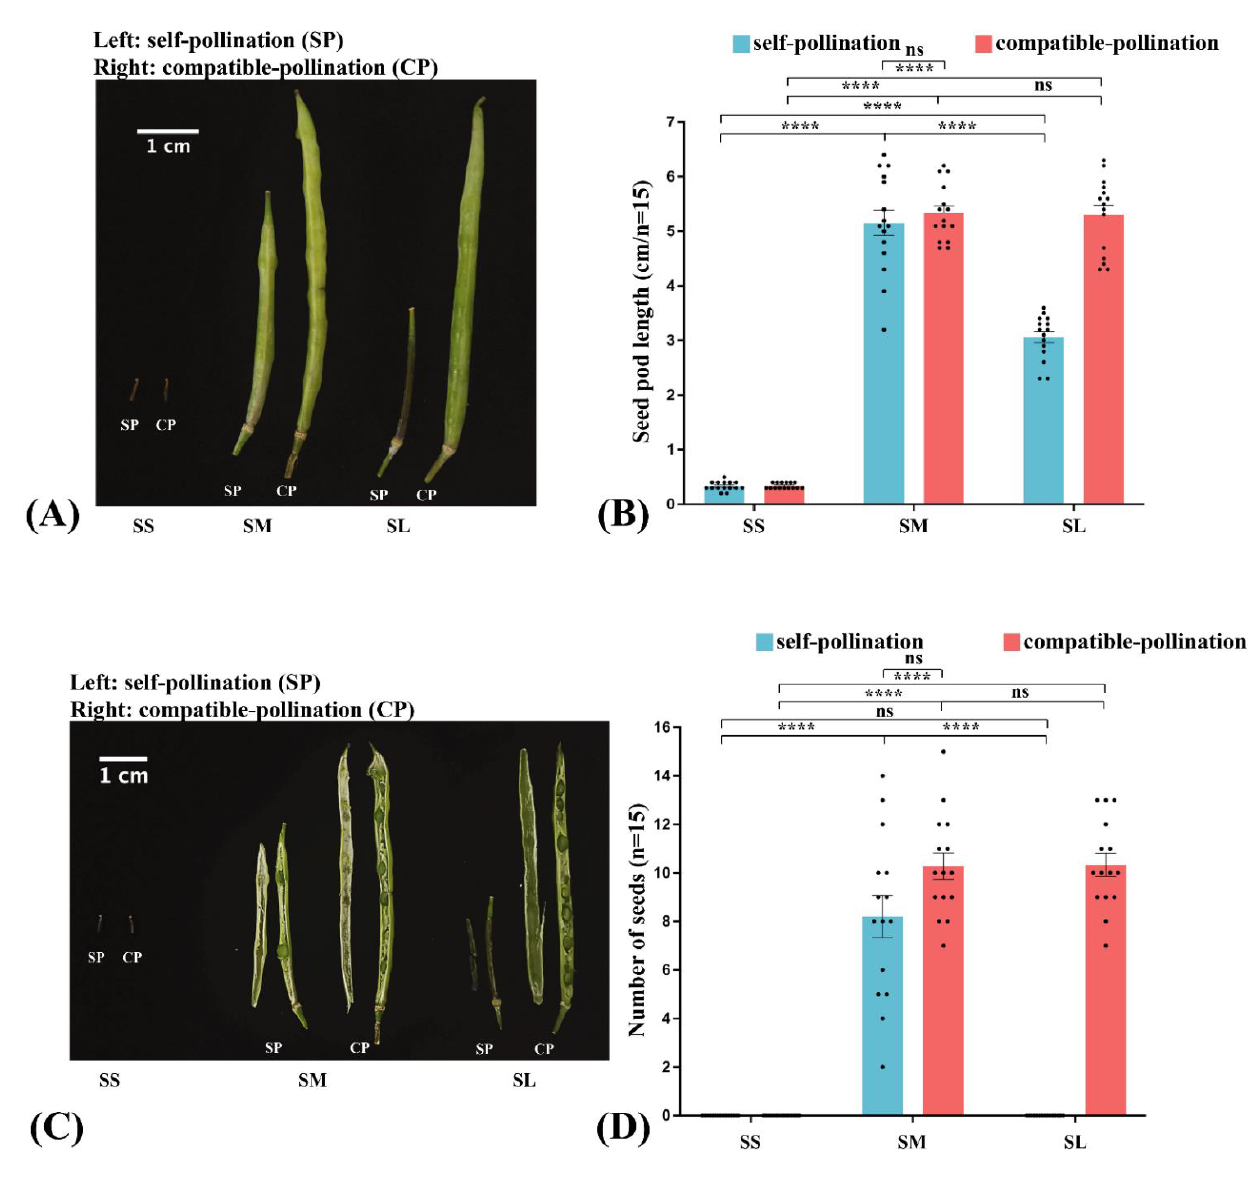
Figure 2. Observation of seed pod length and seed number at different stigma developmental stages after self-incompatible (SI) and compatible pollination (CP). ( A ) Seed pod morphology were observed after different pollination, ( left ): SI; ( right ): CP. ( B ) Seed pod length were counted after different pollination. ( C ) Seed morphology were observed after different pollination, left : SI; right : CP. ( D ) Seed numbers were counted after different pollinations. Asterisks indicate significant difference (**** p < 0.0001 by Student’s t -test), ns indicate no significant difference. Error bars represent the standard error of the mean (n = 15). Scale bars = 1 cm.